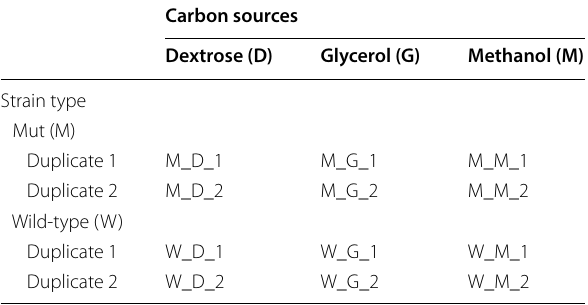
Mut indicates the genetically engineered P. pastoris strain Δmig1Δmig2Δnrg1 -